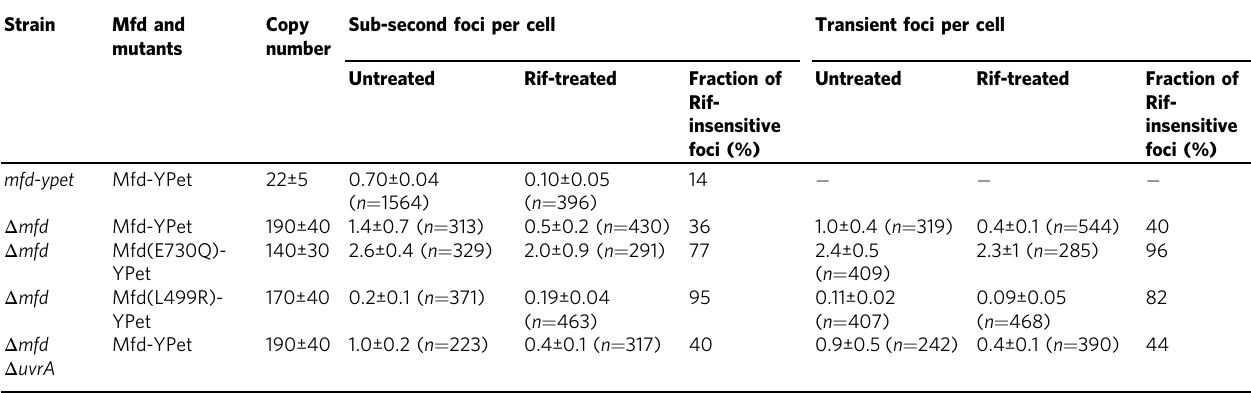
Table 1 Sub-second and transient foci per cell exhibited by Mfd-YPet and mutants in untreated and Rif-treated cells Strain Mfd and